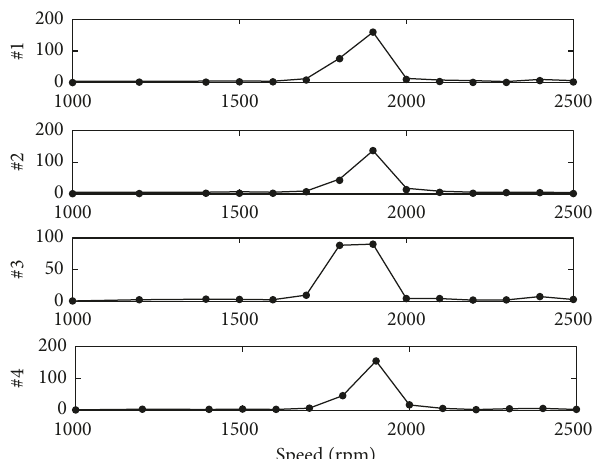
Figure 4: Estimated residual vibration response of measuring planes A and B. #1–#4 correspond to the four measuring directions.